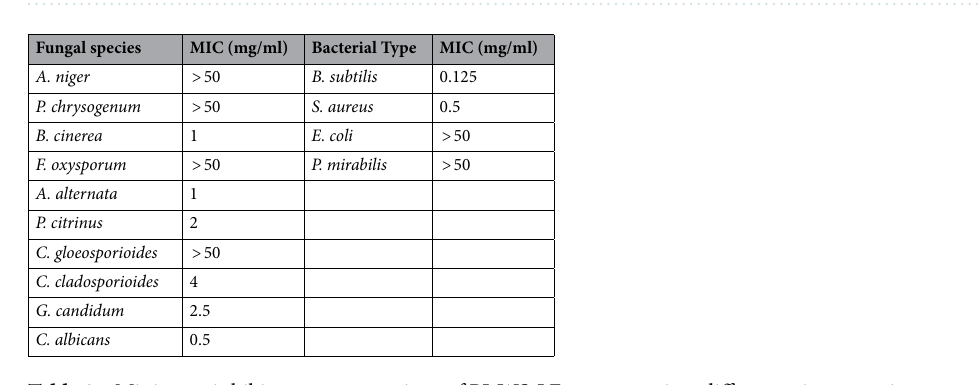
Table 3. Minimum inhibitory concentrations of PJ-WS-LE extract against different